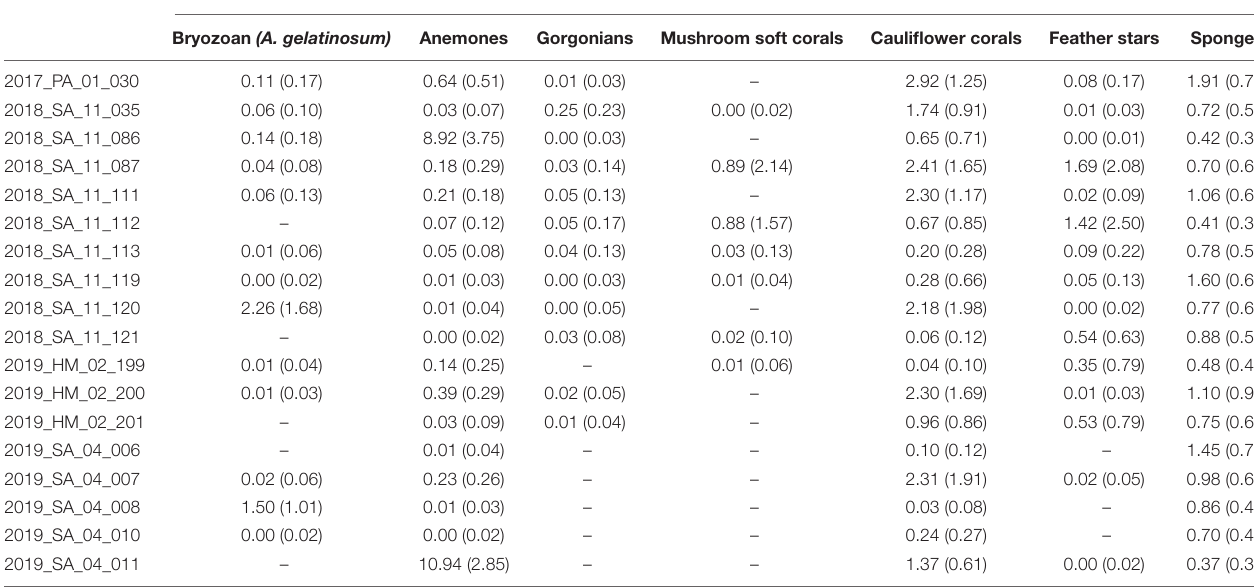
Station Mean (standard deviation) density, individuals or colonies m − 2 Bryozoan (A. gelatinosum)